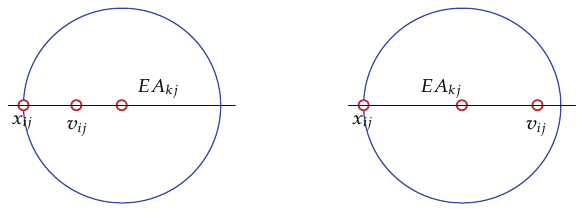
Figure 3: Possible search regions per dimensions: 0 < φ j < 1 (cid:3) left (cid:4) ; 1 < φ j < 2 (cid:3) right (cid:4) .